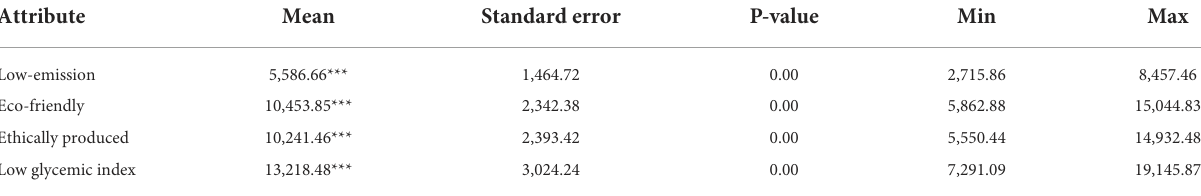
TABLE 7 Marginal WTP